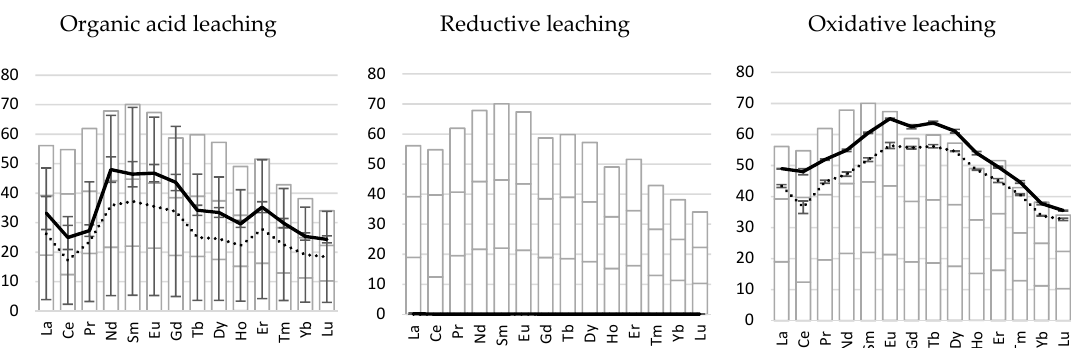
Figure 7. Recovery (%) of individual REE from clay-rich bauxite for each of the leaching techniques tested. Solid lines represent inoculated tests and dotted lines are uninoculated controls. Error bars are plus or minus one standard deviation of triplicate experiments. Bar charts shows sequential extraction data, as in Figure 4.